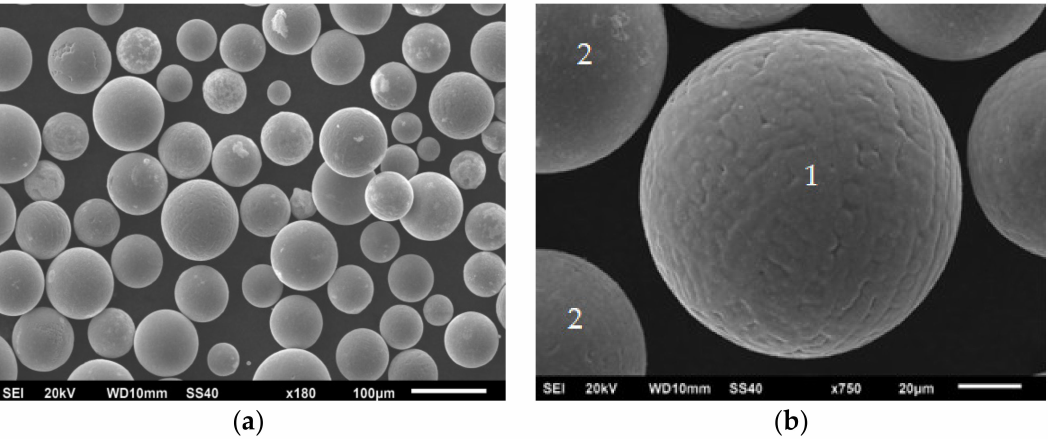
Figure 3. SEM secondary-electron images displaying the particle shape of the spheroidised powder ( a ) and the particle surface (coarse (labelled 1) and smooth (labelled 2) surface morphologies) ( b